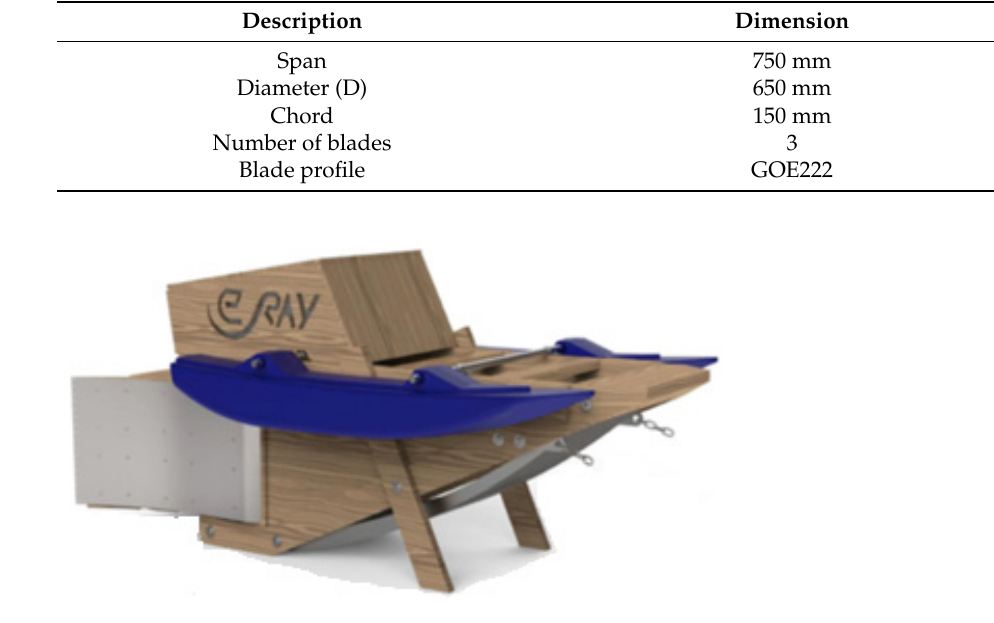
Figure 1. Floating station.